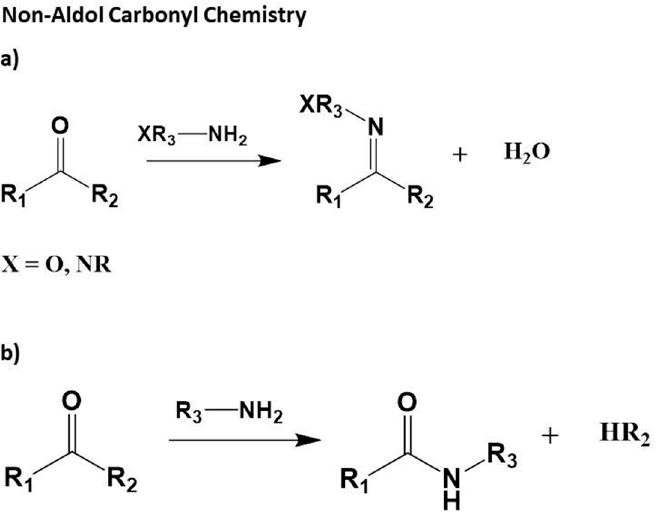
Figure 15. Non-aldol carbonyl click reactions for the ( a ) hydrazone/oxime ether and ( b ) amide/isourea formation.